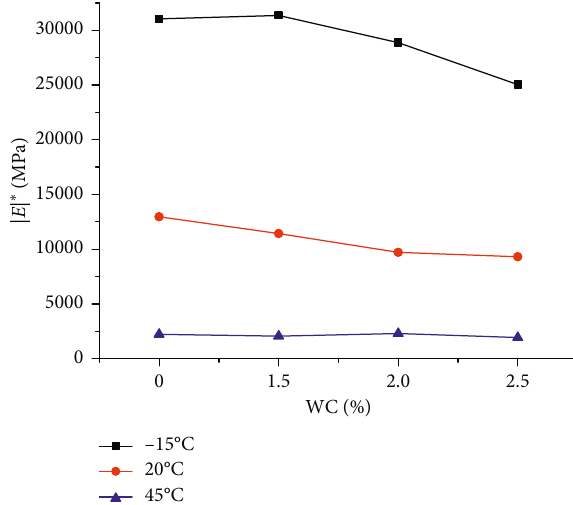
Figure 17: 70#AC-20-type dynamic modulus varying with water consumption and temperature.